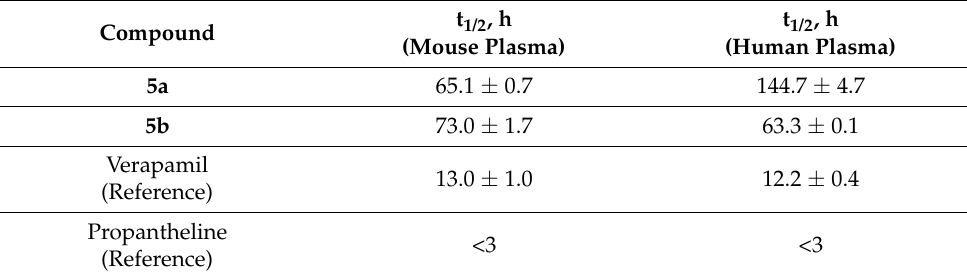
Table 2. Mouse and human plasm stability for prodrugs 5a,b, t 1/2 : half-life.